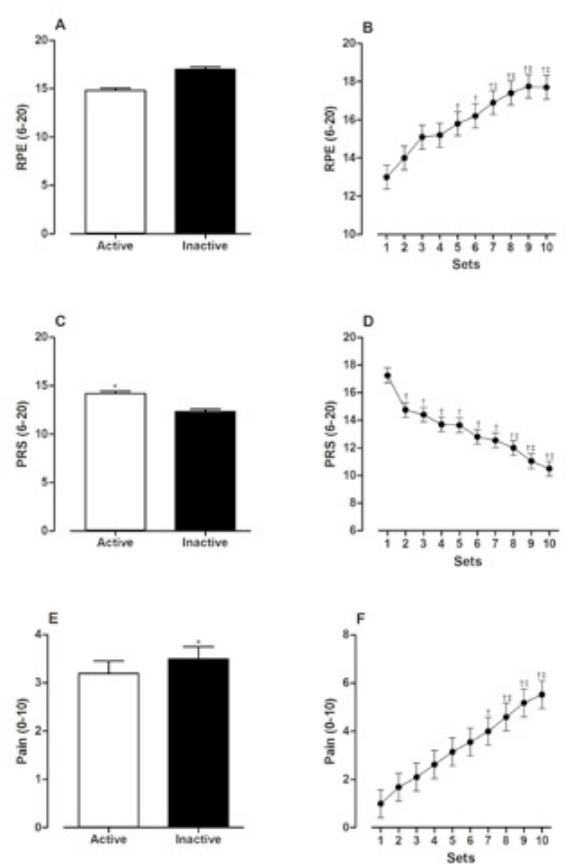
Figure 3. Values expressed in mean ± standard deviation in pre-exercise (0), and at the end of each set of 10 repetitions in the knee extension isokinetic exercise, between active and inactive subjects. Panels A and B: subjective perception of effort (SPE). Panels C and D: subjective perception of recovery (SPR). Panels E and F: pain.